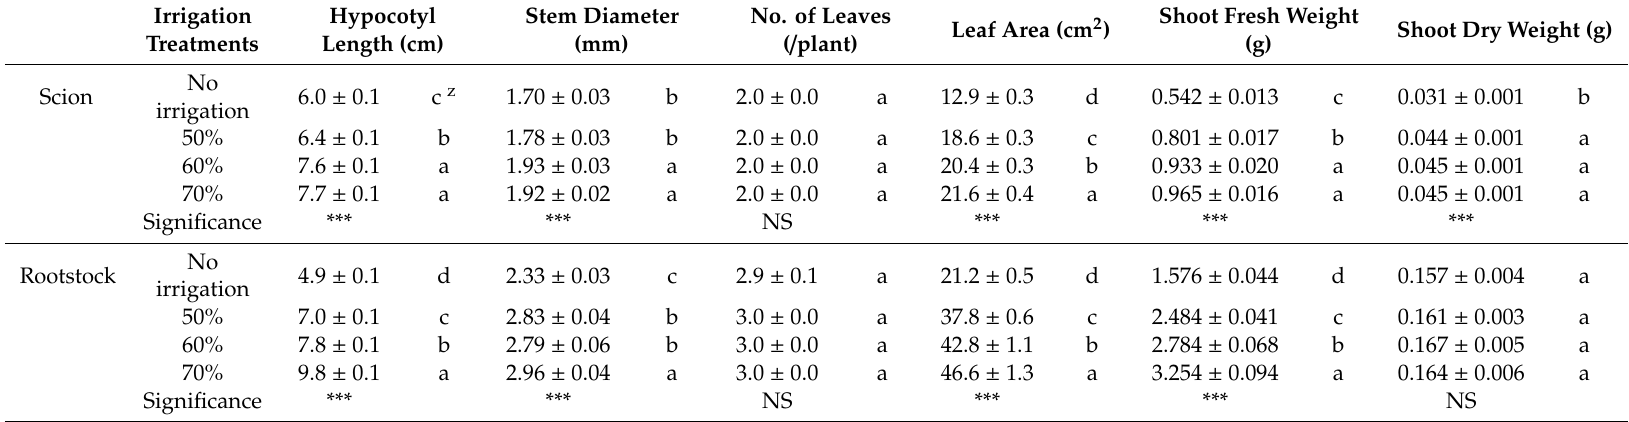
Table 1. Hypocotyl length, stem diameter, number of leaves, leaf area, shoot fresh and dry weight of cucumber scions and rootstocks as a ff ected by di ff erent irrigation regimens during cultivation in a PFAL ( n = 7, R = 3).